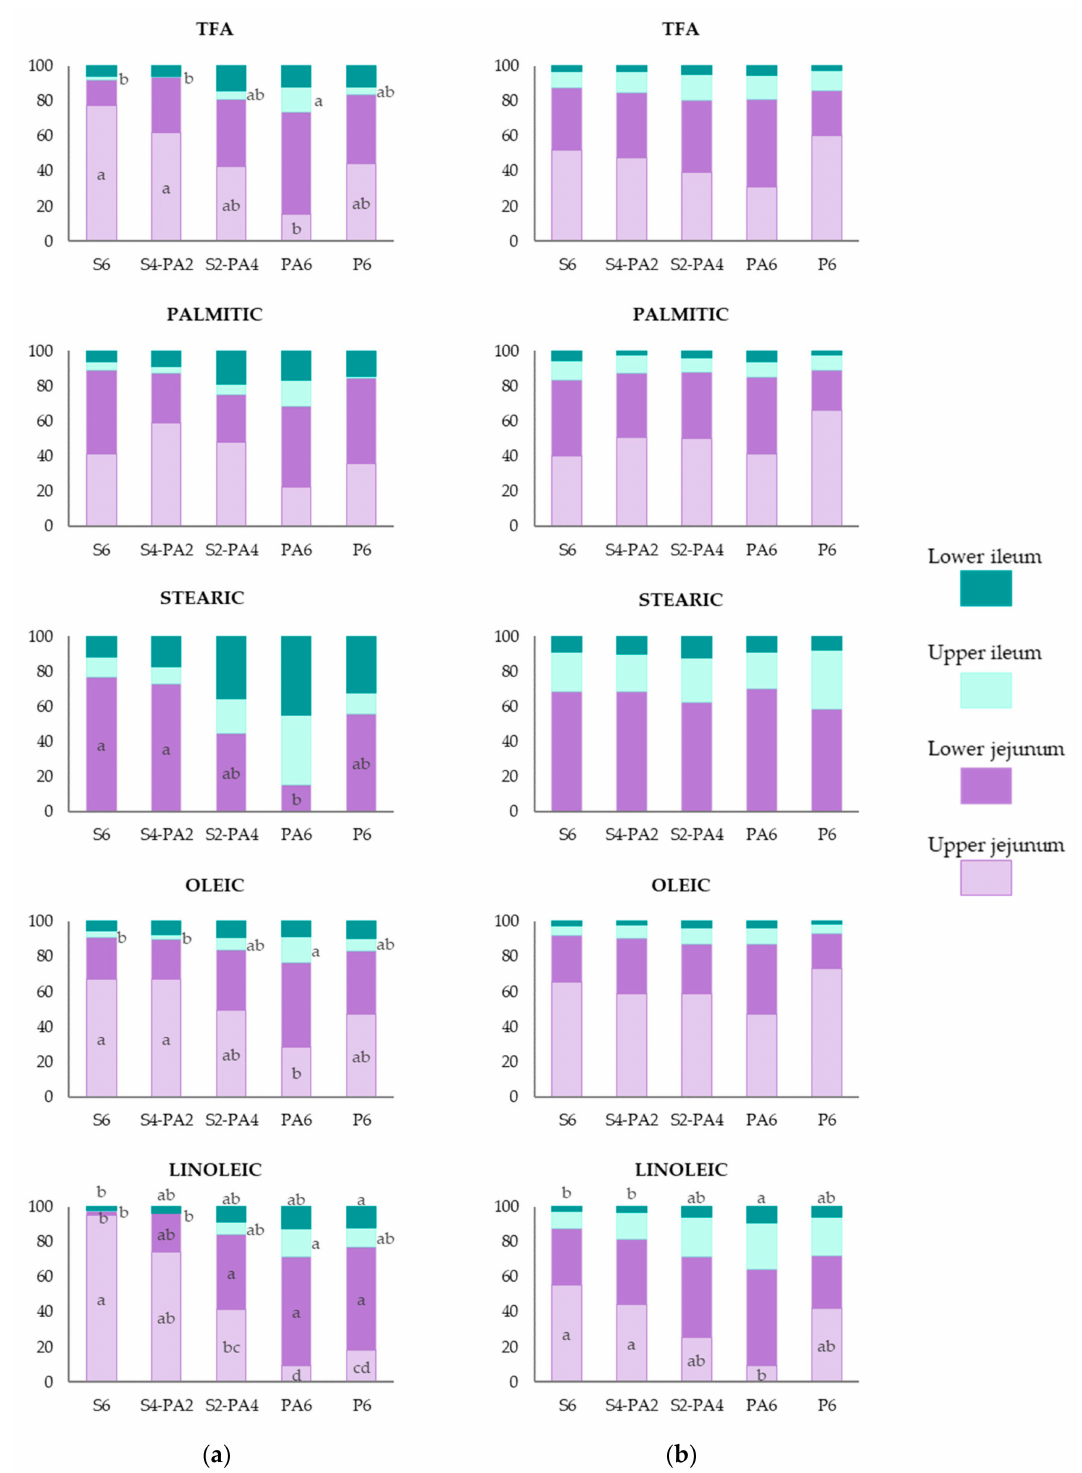
Figure 2. Contribution of each intestinal segment to the apparent fatty acid digestibility, calculated as a proportion of total digestibility reached at the lower ileum, along the intestinal tract for the five different diets; with 6% of soybean oil (S6), blend with 4% soybean oil and 2% palm fatty acid distillate (S4-2PA), blend with 2% soybean oil and 4% palm fatty acid distillate (S2-2PA), with 6% of palm fatty acid distillate (PA6) and with 6% palm oil (P6) in ( a ) 11-d-old broiler chickens and ( b ) 35-d-old broiler chickens. TFA (Total Fatty Acids), Palmitic (C16:0), stearic (C18:0), oleic (C18:1n-9) and linoleic (C18:2n-6) acids. Values are means of 6 replicates per each diet with 12 chickens/replicate at 11 d, and 2 chickens/replicate at 35 d. a–d: columns with the same intestinal segment not sharing a common letter are significantly different ( p <